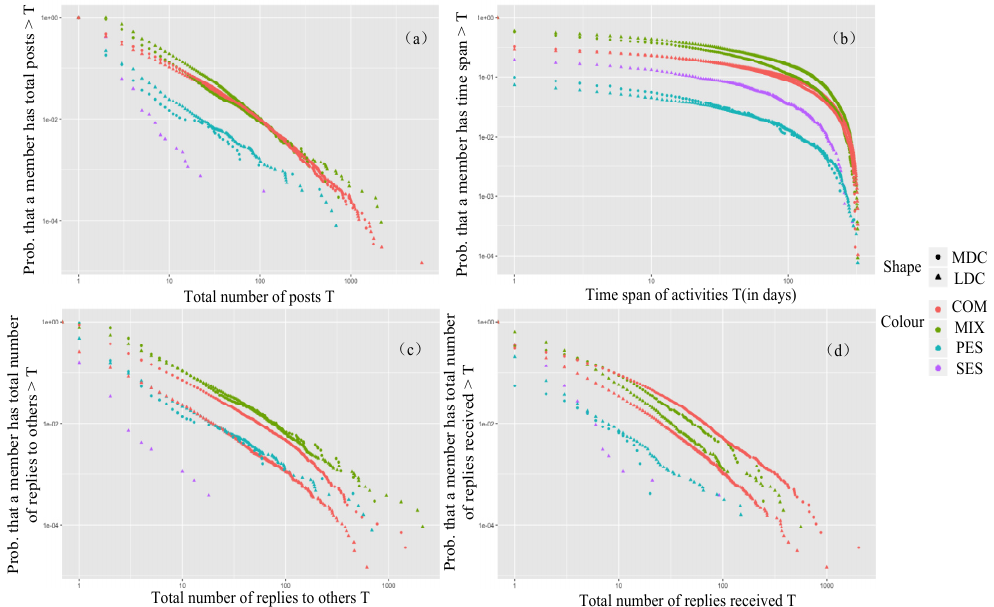
Figure 5. Complementary cumulative distributions of engagement metrics for the different clusters of emotional support: ( a ) productivity, ( b ) loyalty, ( c ) social activity, and ( d ) attention received.